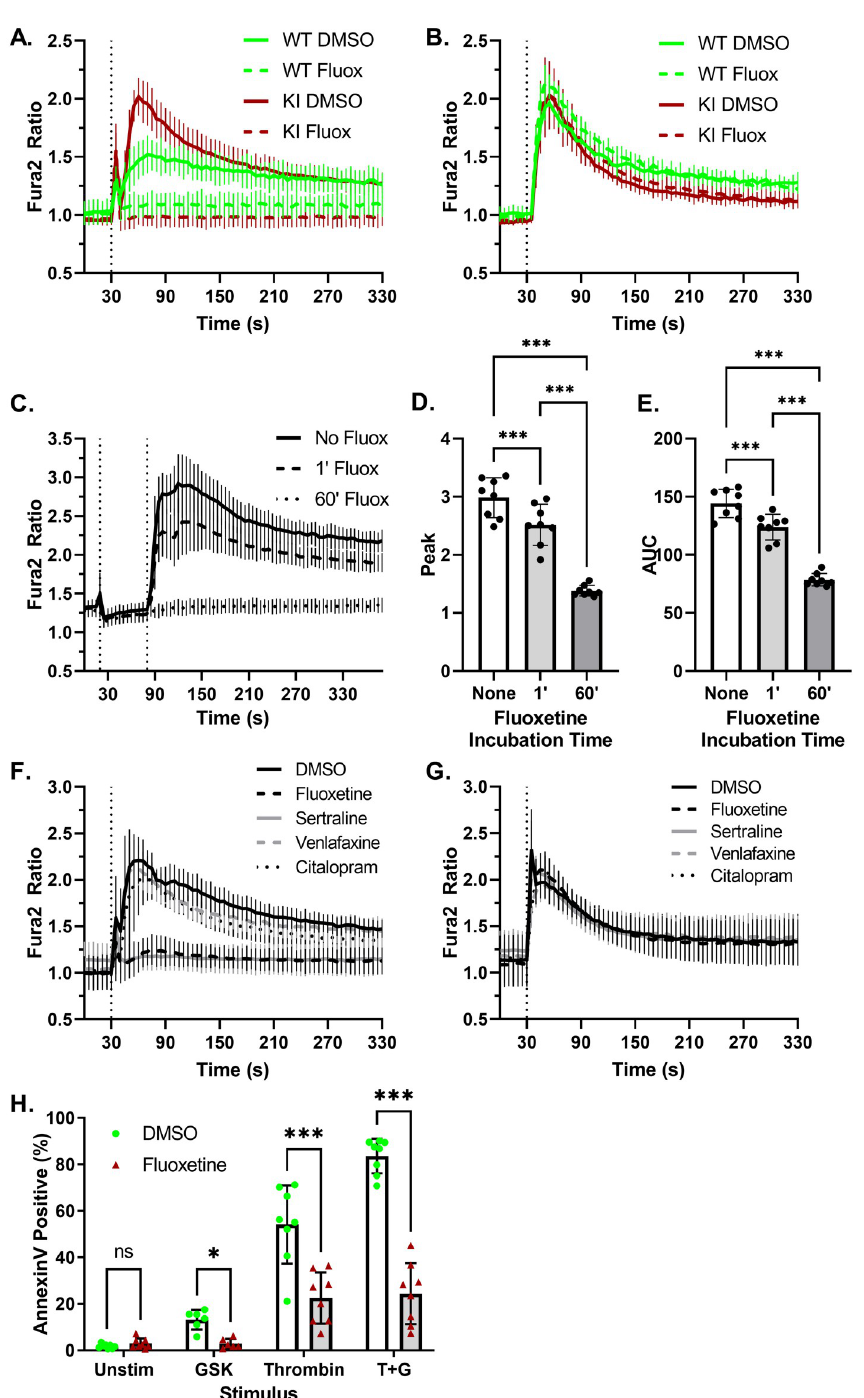
Fig 7. Fluoxetine inhibits TRPC6-mediated calcium influx and phosphatidylserine exposure. A, WT and KI platelets, pre-incubated in the presence of vehicle (DMSO) or fluoxetine (10 μ M), were subject to Fura-2 ratiometric imaging. GSK was added after 30 seconds. N = 3–6. B, platelets were pretreated as in (A) followed by stimulation with ADP. N = 2–4. C, KI platelets were pre-incubated with (60’ Fluox) or without fluoxetine followed by Fura2 analysis. Fluoxetine (1’ Fluox) or vehicle (No Fluox and 60’ Fluox) was added to the platelets after 20 seconds (first vertical line) followed by GSK at 80 seconds; n = 8. Fura-2 fluorescence ratio peak (D) and area under the cure (E) are shown. One way ANOVA with Tukey’s multiple comparisons test. F-G, Fura-2 imaging of KI platelets, pre-incubated with DMSO or the indicated drug (all 10 μ M), and stimulated with GSK (F) or ADP (G) after 30 seconds; n = 5–6. H, percentage of